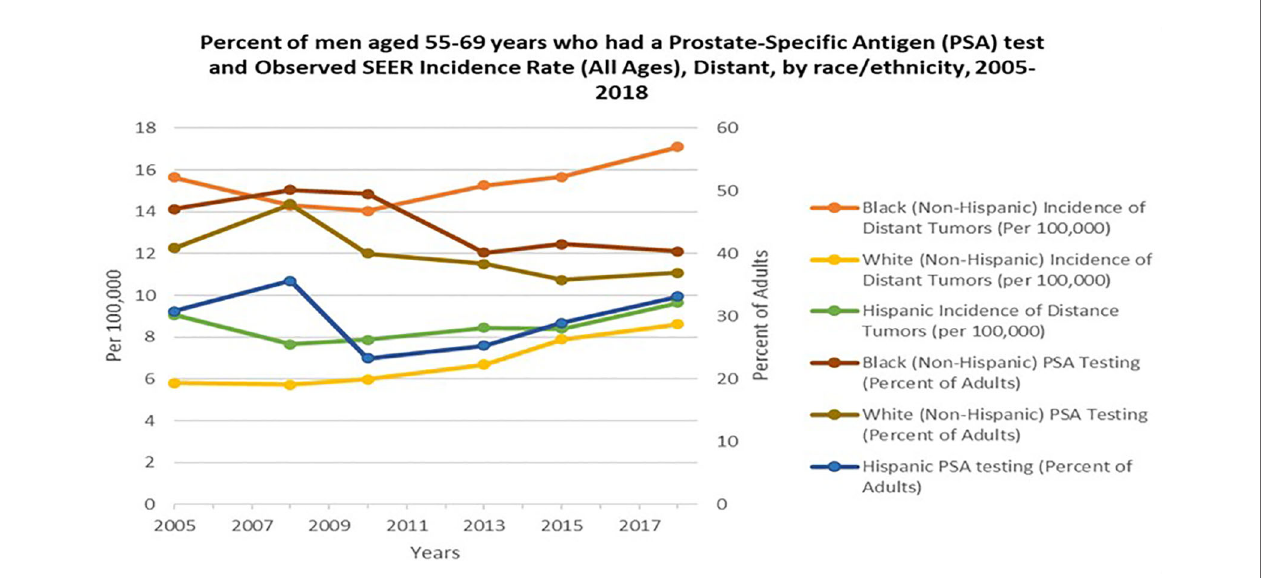
FIGURE 2 | Percent of men aged 55-69 years who had a Prostate- Speci fi c Antigen (PSA) test and Observed SEER Incidence Rate (All Ages), Distant, by race/ ethnicity, 2005-2018. Orange, Yellow and Green lines represent Black, NHW (non-Hispanic white) and Hispanic incident of distant tumors per 100,000 persons in the U.S, respectively. Burgundy, Brown, and Blue lines represent Black, NHW (non-Hispanic white) and Hispanic PSA testing percent of adults in the U.S. Data adapted from Centers for Disease Control and Prevention, National Center for Health Statistics, National Health Interview Survey, 2005-2018 and SEER 21 areas estimates for a speci fi c stage at diagnosis (Localized, Regional, Distant or Unknown/Unstaged) (29,